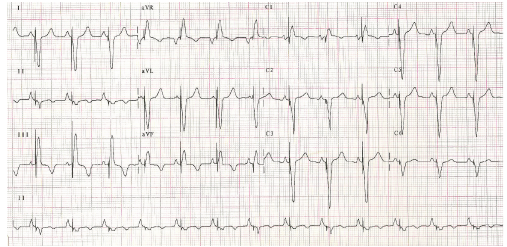
Figure 4: ECG after CRT